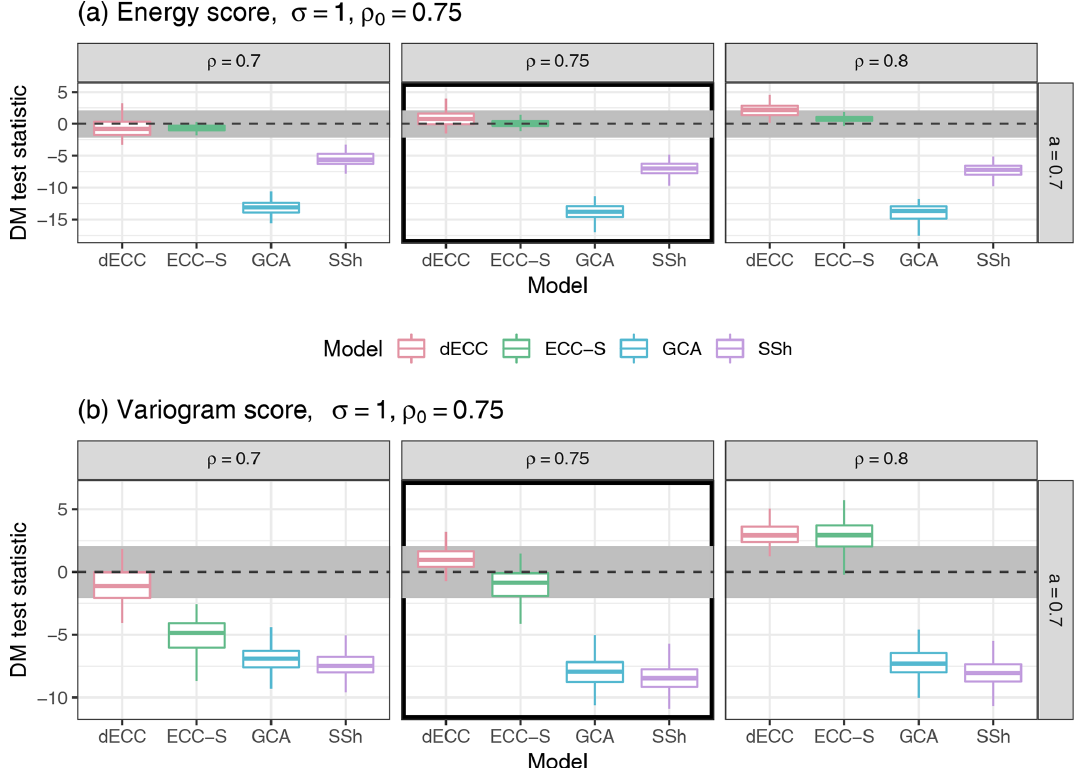
Figure 7. Summaries of DM test statistic values based on the ES (a) and the VS (b) for Setting 3B for σ = 1 and high values of ρ,ρ 0 . ECC-Q forecasts are used as a reference model such that positive values of the test statistic indicate improvements over ECC-Q and negative values indicate deterioration of forecast skill. Boxplots summarize results of the 100 Monte Carlo repetitions of each individual experiment. The horizontal gray stripe indicates the acceptance region of the two-sided DM test under the null hypothesis of equal predictive performance at a level of 0.05. Simulation parameter choices where the correlation structure of the raw ensemble is correctly specified ( ρ = ρ 0 ) are surrounded by black